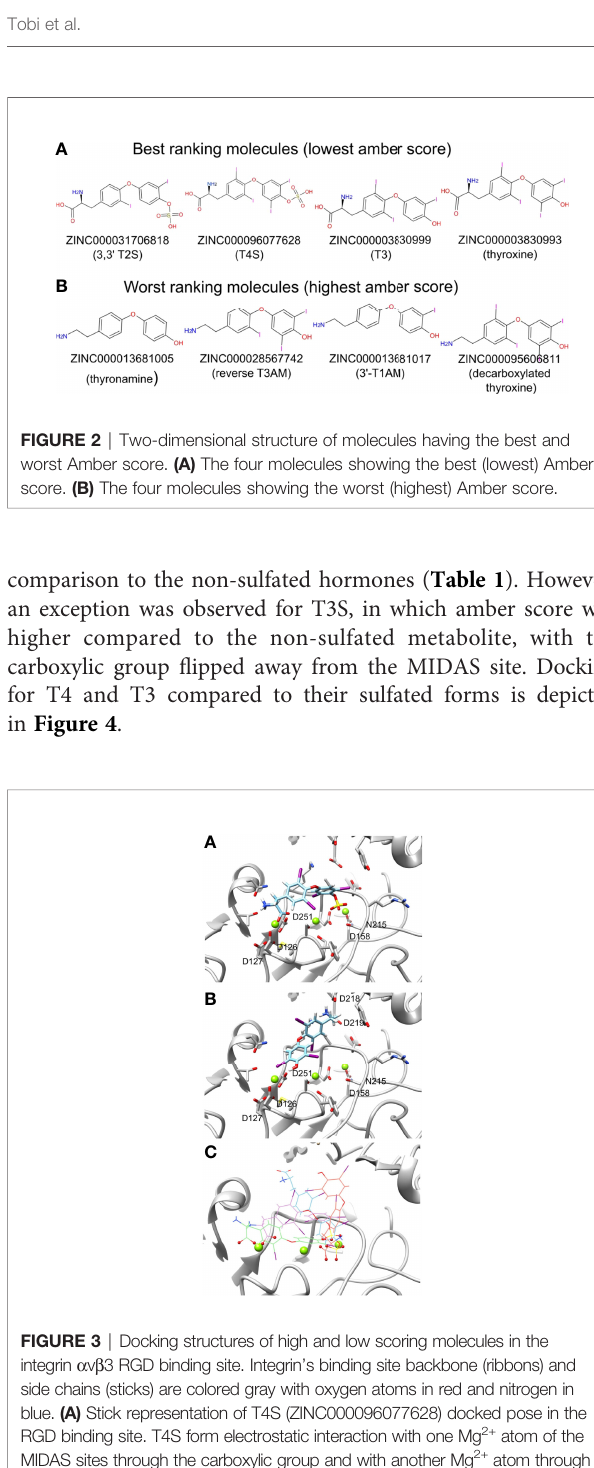
FIGURE 3 | Docking structures of high and low scoring molecules in the integrin a v b 3 RGD binding site. Integrin ’ s binding site backbone (ribbons) and side chains (sticks) are colored gray with oxygen atoms in red and nitrogen in blue. (A) Stick representation of T4S (ZINC000096077628) docked pose in the RGD binding site. T4S form electrostatic interaction with one Mg 2+ atom of the MIDAS sites through the carboxylic group and with another Mg 2+ atom through the sulfate group. (B) T4AM (decarboxylated thyroxine, ZINC000095606811) docked pose does not form electrostatic interactions with Mg 2+ atoms. (C) Docked poses of the four molecules showing the lowest Amber score. The molecules are depicted using wire representation and the negatively charged oxygens of the carboxylic and sulfate groups are presented as red spheres. The Mg 2+ atom is shown as green sphere and docked structures are colored as follows: 3,3 ’ T2S carbon (cyan), T4S carbon (orchid), T3 carbon (green), thyroxine (orange), nitrogen (blue), oxygen (red), hydrogen (white), iodine (purple), and sulfur (yellow). For clarity the oxygen atoms are presents as smaller spheres compared to the Mg 2+ atoms although their actual atomic radius is larger.